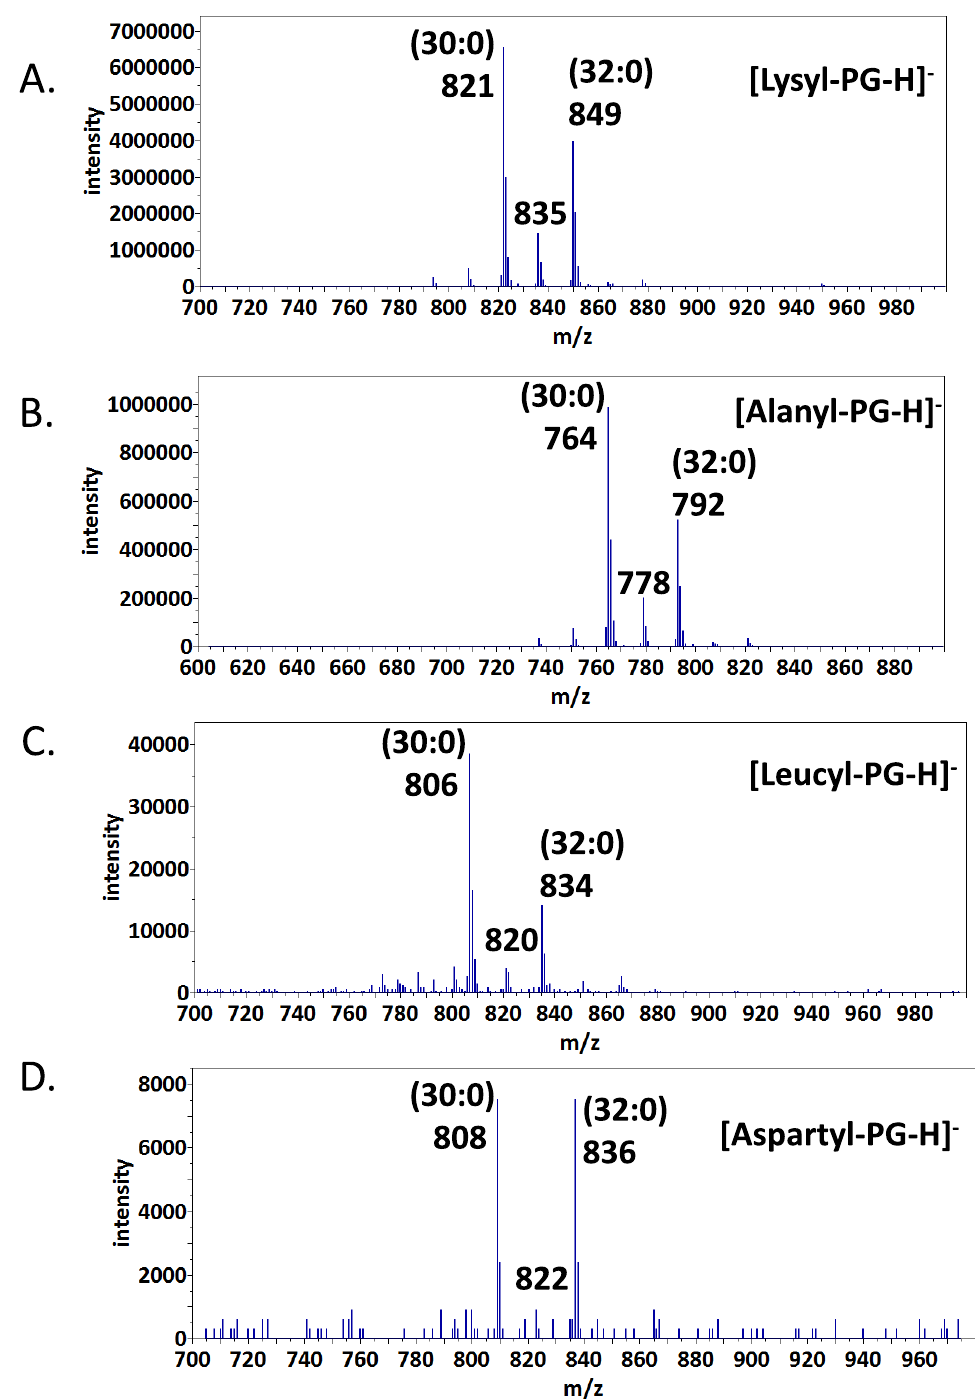
Figure 3. Precursor scans for aminoacyl-PGs. Major peaks in the spectra are labeled with fatty acid composition (number of carbon atoms: number of desaturation). A . Scan for precursors of a 145 amu anion. B . Scan for precursors of a 88 amu anion. C . Scan for precursors of a 130 amu anion. D . Scan for precursors of a 132 amu